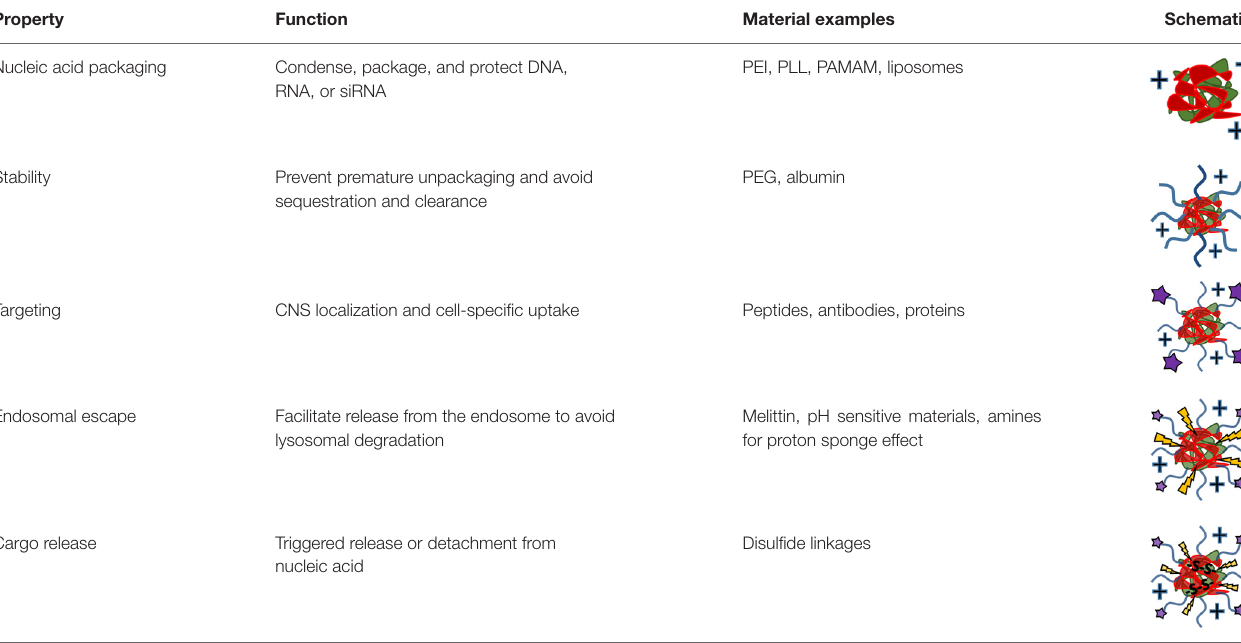
TABLE 1 | Properties of effective nucleic acid delivery vehicles.